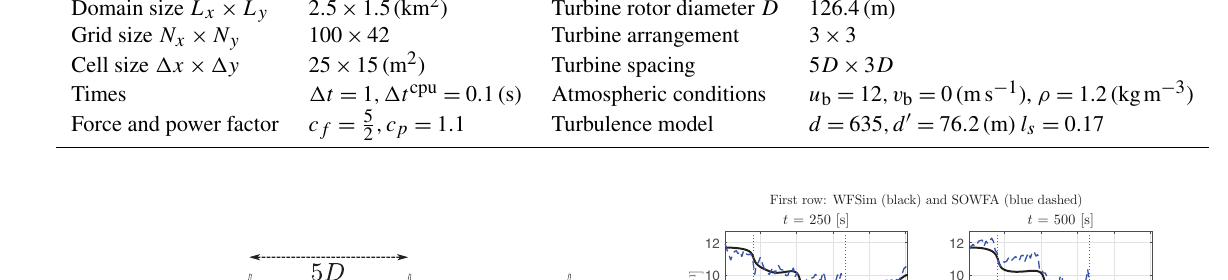
Table 3. Summary of the WFSim simulation set-up.